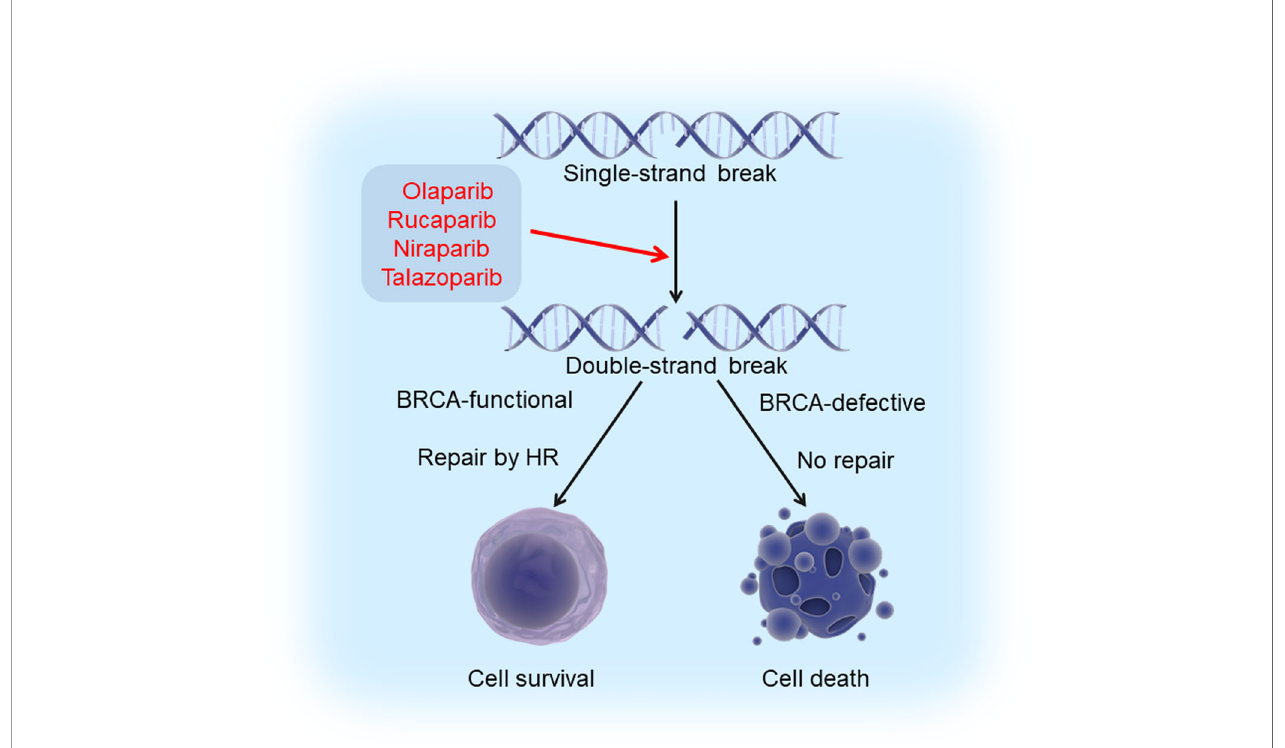
FIGURE 1 | Synthetic lethality induced by PARPi ’ s and BRCA de fi ciency. Exposure of cells to PARPi ’ s (olaparib, rucaparib, niraparib, and talazoparib) leads to the formation of double strand breaks (DSBs) from single strand breaks (SSBs). Cells with intact BRCA function could survive since these breaks can be repaired by homologous recombination, while those with defective BRCA die because DSBs cannot be repaired. This phenomenon is known as “ synthetic lethality ”